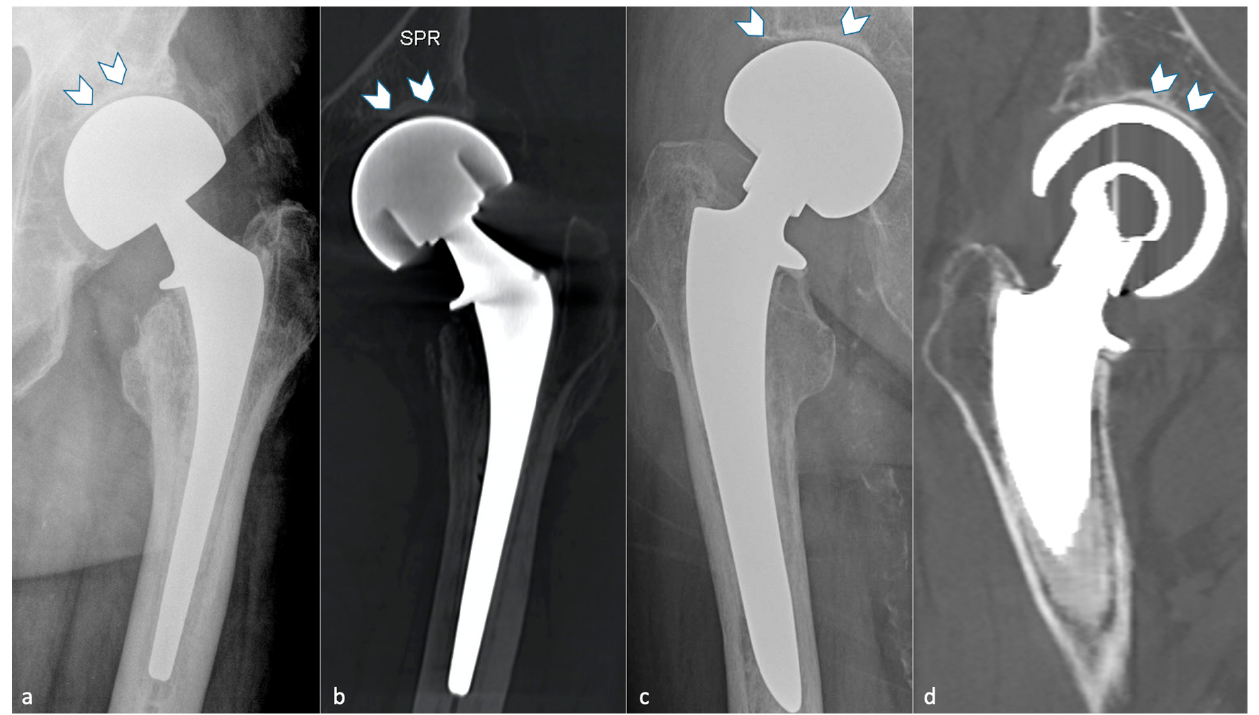
Figure 2. Hip hemi ‐ arthroplasties. A unipolar arthroplasty is shown on ( a ) an antero ‐ posterior hip Figure 2. Hip hemi-arthroplasties. A unipolar arthroplasty is shown on ( a ) an antero-posterior hip radiograph and ( b ) a coronal slice of CT ‐ MAR. A bipolar arthroplasty is shown on ( c ) an antero ‐ radiograph and ( b ) a coronal slice of CT-MAR. A bipolar arthroplasty is shown on ( c ) an antero- posterior hip radiograph and on ( d ) a coronal slice of CT ‐ MAR. Note that the native acetabulum can posterior hip radiograph and on ( d ) a coronal slice of CT-MAR. Note that the native acetabulum can be seen on all imaging modalities in both cases (white arrowhead). be seen on all imaging modalities in both cases (white